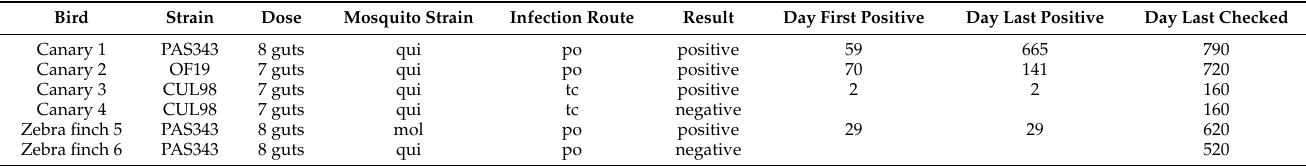
Table 2. Results of bird inoculations. Birds were inoculated perorally (po) or transconjunctivally (tc) with T. thomasbancrofti from the laboratory-reared mosquitoes Cx. molestus (mol) and Cx. quinquefasciatus